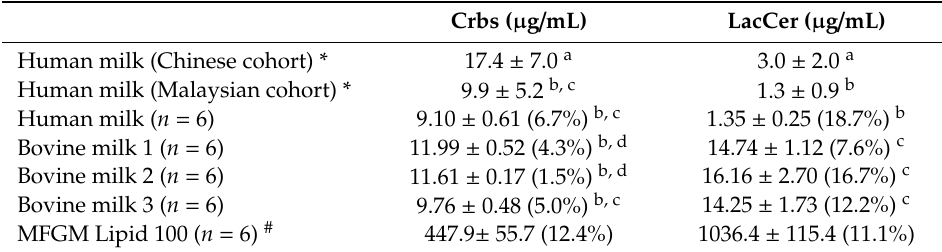
Table 4. Average concentrations ± standard deviations of Crbs and LacCer in human milk, bovine milk and MFGM Lipid 100 (coe ffi cients of variation in parentheses).